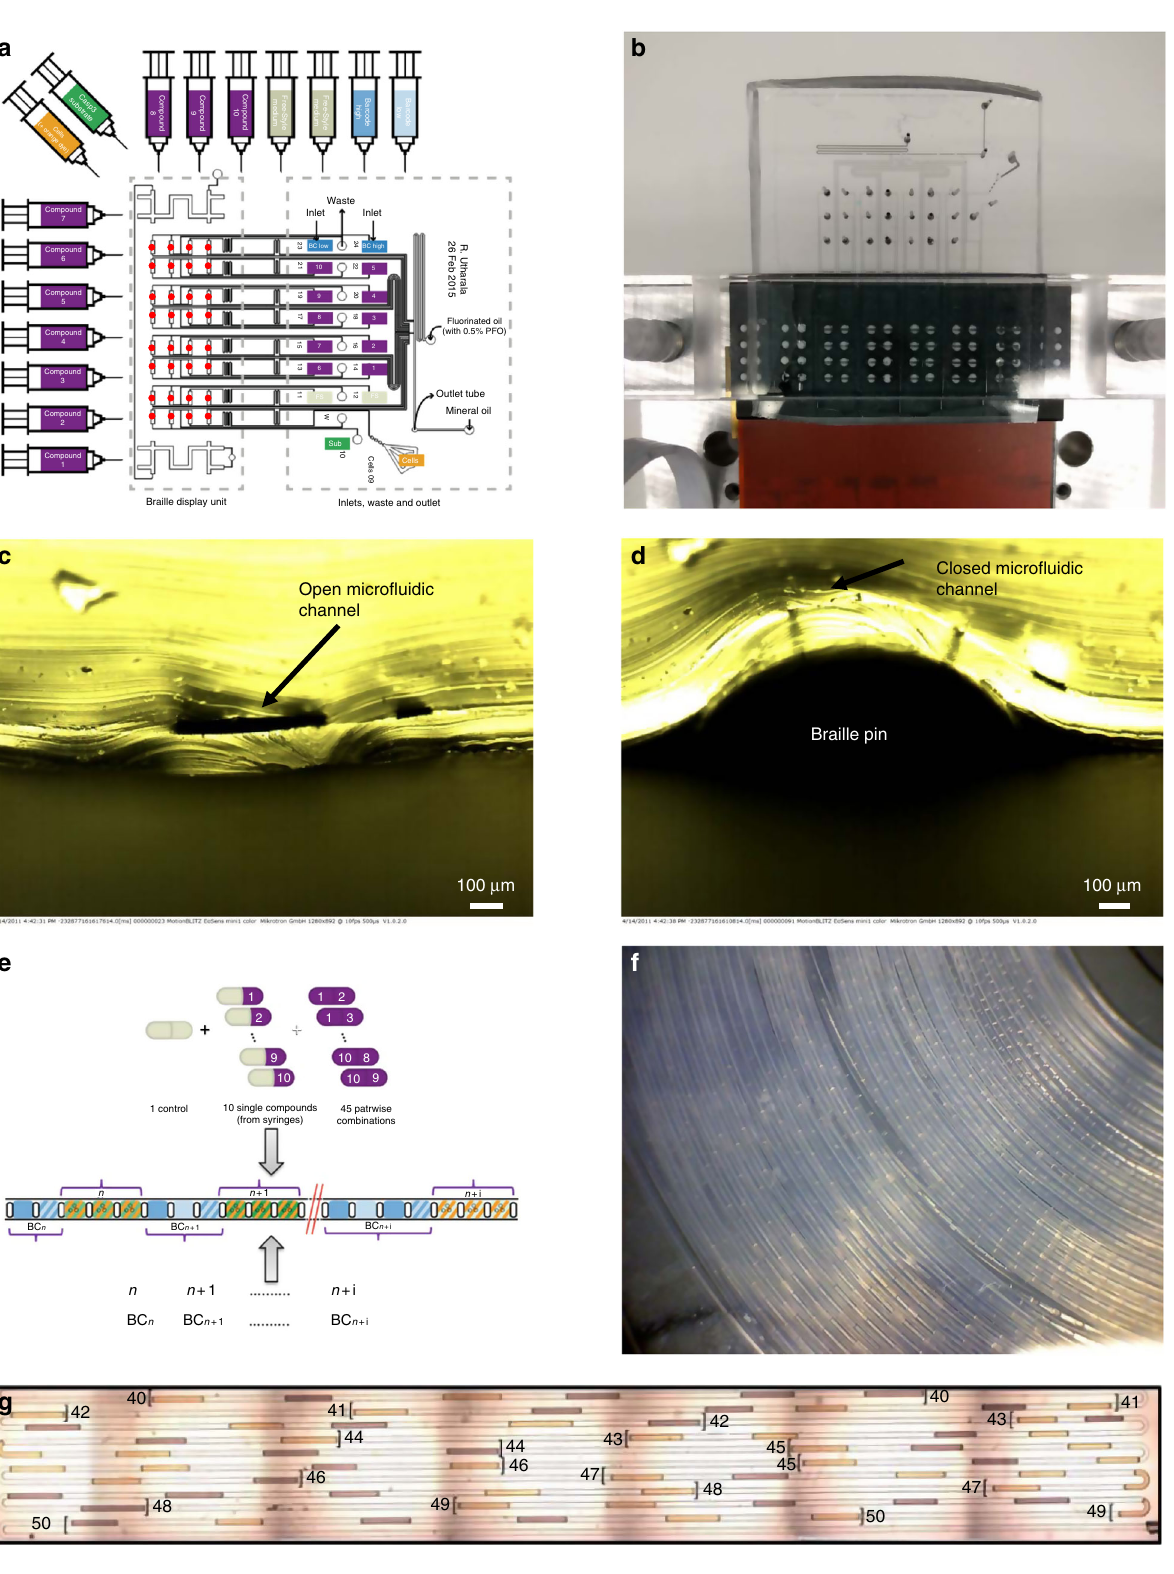
detection module. In our case, we used an optical setup (Supplementary Fig. 4) with three different excitation lasers (375, 488 and 561 nm) and performed a multiplexed readout at three different wavelengths (450, 521 and >580 nm) to allow highly multiplexed assays in the blue, green and red spectrum,